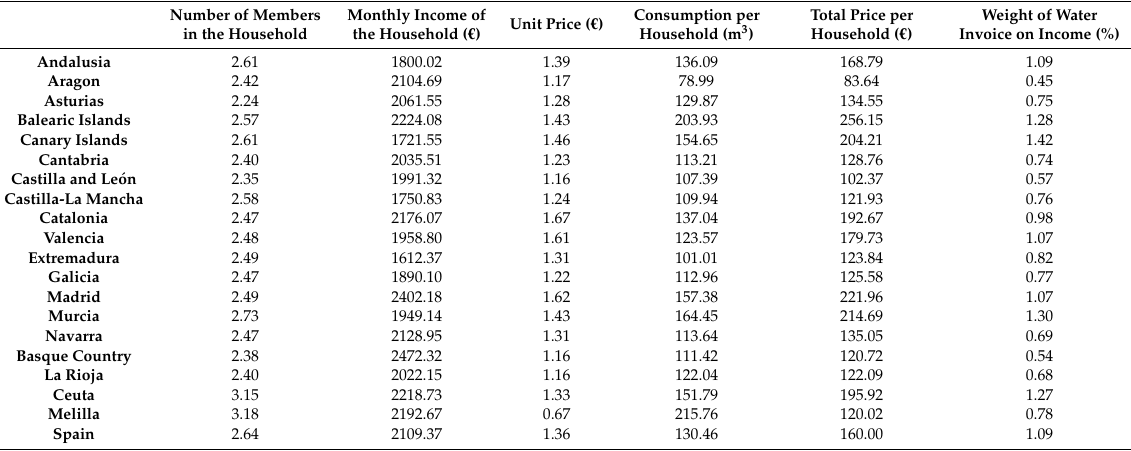
Table A5. Averages of the main variables of the analysis by region and for the total of Spain. Number of Members in the Household